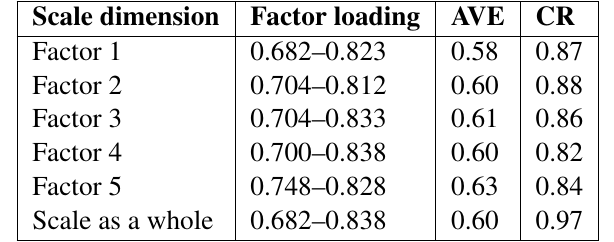
Table 5 Convergence validity test table of the Chinese version of PHCI